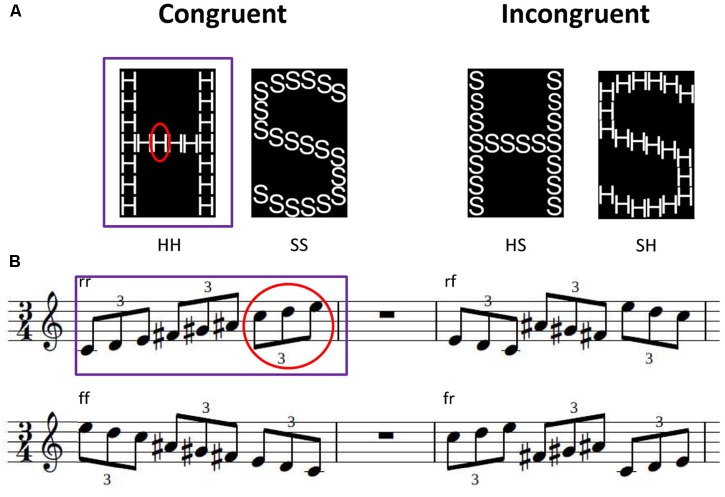
Examples of visual and auditory hierarchical stimuli of the Hierarchical letters (A) and Auditory global-local test (B). Experiments are divided into two blocks, in which participants have to concentrate either on local elements (red; small letters or tone triplets) or on global shape (purple; big letter shape or whole melody). The resulting stimuli can be congruent (e.g., HH: big H, small H; rr = rising tones within whole melody and within triplets) or incongruent (e.g., SH: big S, small H; rf = rising tones within whole melody but falling within triplets). Melodic stimuli occur in different transpositions across all possible tonalities.